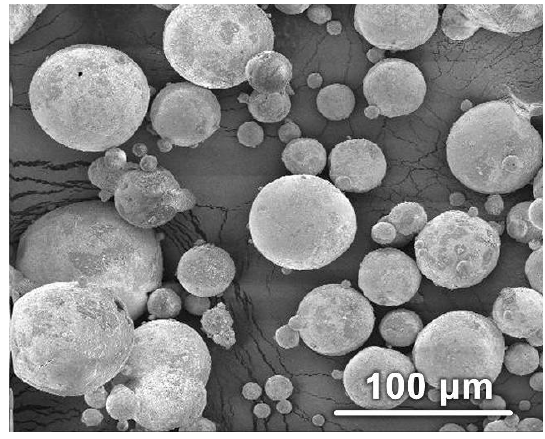
Table 3. Parameters of micro-arc oxidation.